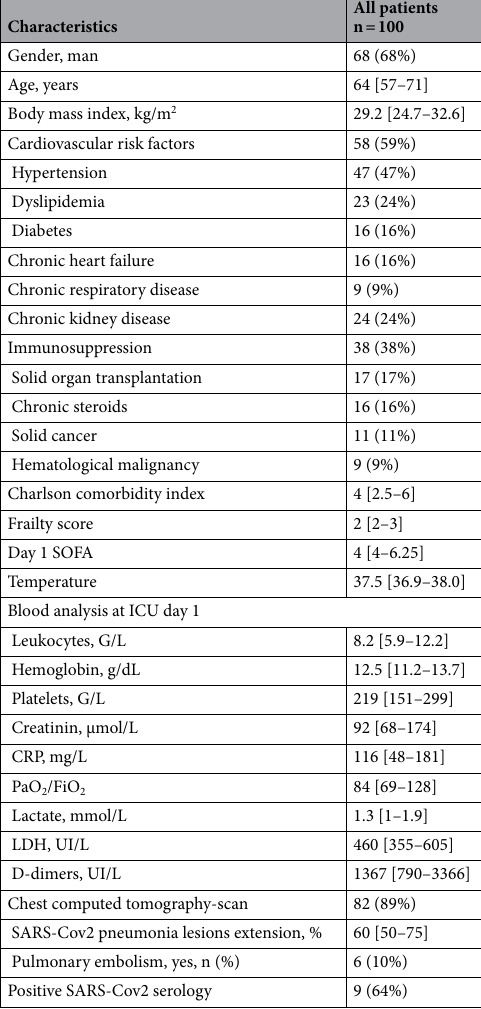
Table 1. Characteristics of 100 vaccinated patients with critically ill SARS-Cov2 infection. CRP C-reactive protein, ICU intensive care unit, LDH lactate dehydrogenase, SARS-Cov2 severe acute respiratory syndrome coronavirus 2, SOFA sequential organ failure